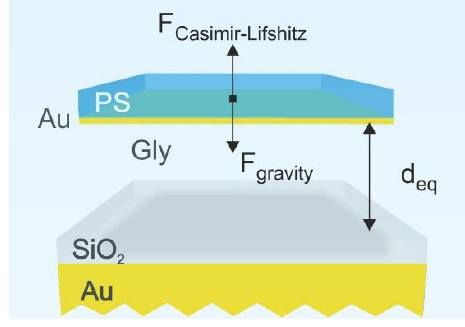
Fig. 1. Scheme of the optical cavity formed by a self-standing thin film made up of gold (Au) and polystyrene (PS) immersed in glycerol over a silica (SiO 2 ) coated gold substrate. Layer thicknesses range from tens to several hundreds of nanometers. The equilibrium distance at which Casimir-Lifshitz and gravity forces are balanced results in (cid:6) (cid:7)(cid:8) of few hundreds of